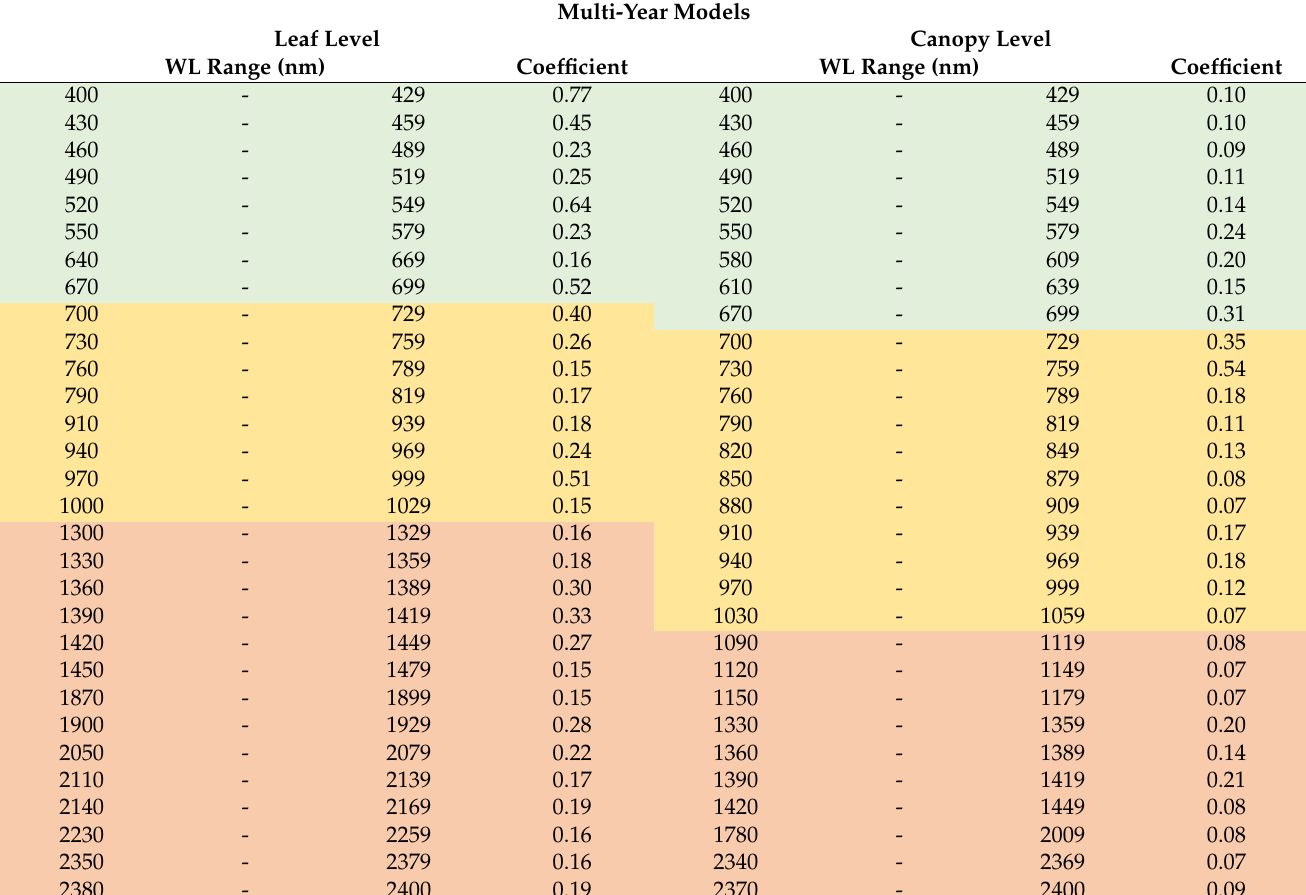
Table A8. Top 30 standardized coefficient values and their respective wavelength ranges from multi-year leaf and canopy models. The coefficient values displayed in this table represent the average standardized coefficient value every 30 nm, as described by the wavelength range (WL Range (nm)). Colors highlighting the three main areas of the full-spectral